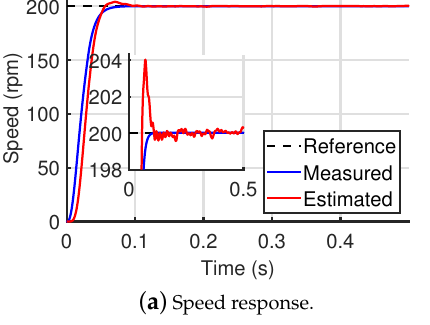
Figure 8. Simulation results under R = 0.1 R 0 .